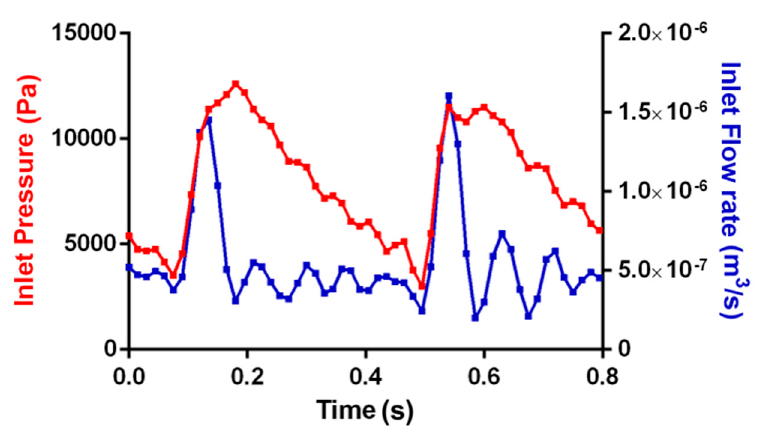
Figure 15. Time evolution of the computational Inlet pressure ( left y-axis ) and Inlet Flow Rate ( right y-axis ).